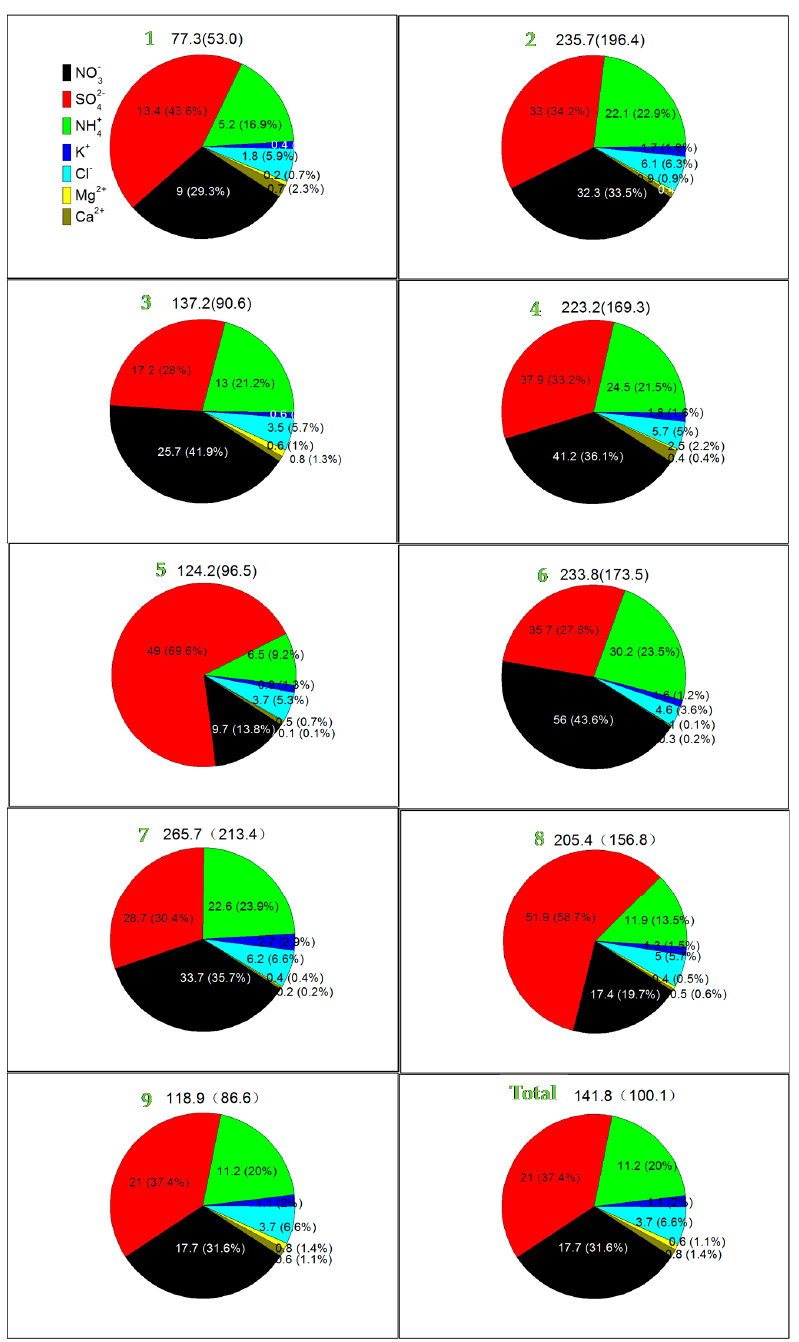
Figure 6. The pie charts show the concentrations ( μ g·m − 3 ) and mass fractions (%) of each aerosol species in TWSIs during pollution Episodes 1–9 and the entire study period (upper part of the figure shows the concentrations of PM 10 and PM 2.5 during these episodes in parentheses).